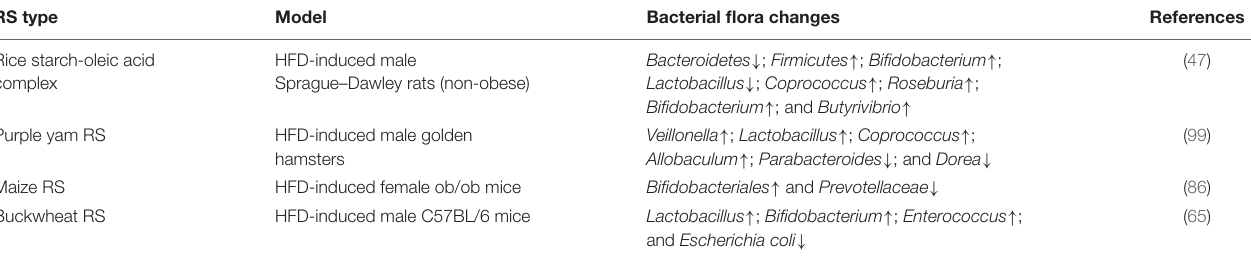
TABLE 2 | Intake of resistant starch (RS)-induced alterations of gut microbiota